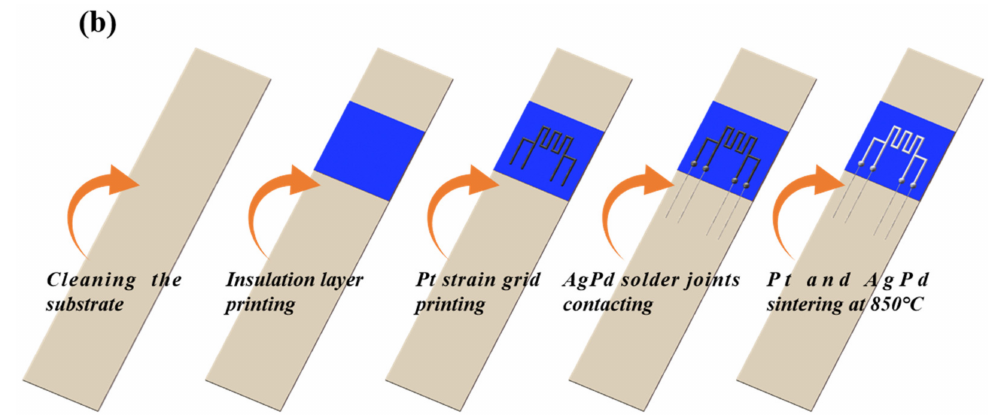
Figure 1. ( a ) Schematic diagram of direct ink writing (DIW) process of Pt paste. ( b ) Process flow diagram of the Pt thin film strain